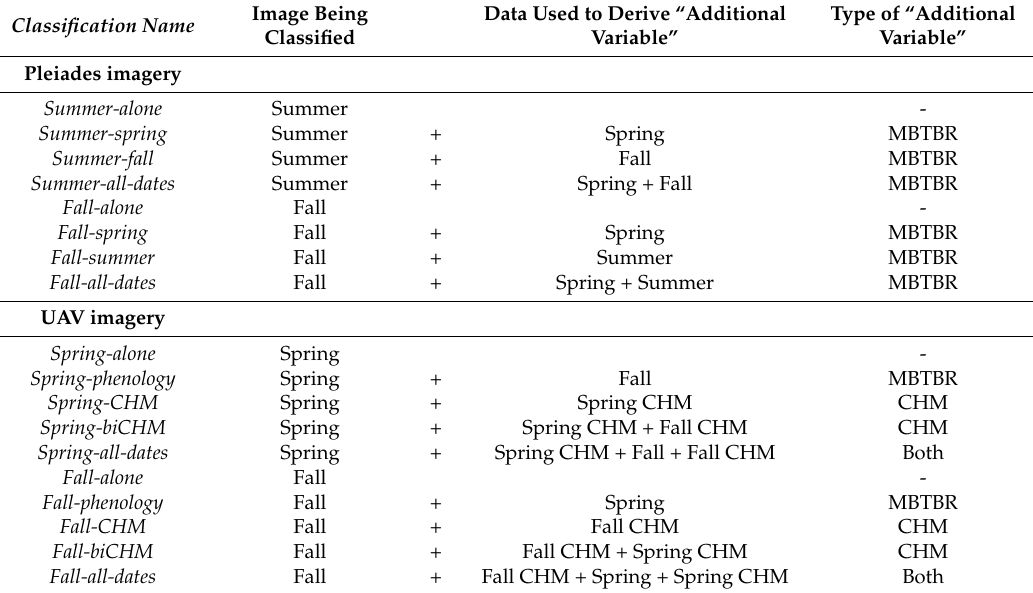
Table 2. Presentation of the classification design used on each site. The “+” sign indicates that a MBTBR or a CHM is added to the features used to classify the image: e.g., for the Summer-spring Pleiades classification, in addition to the features used by Müllerov á et al. [35], a MBTBR index calculated between the Summer and the Spring images is used to classify the Summer